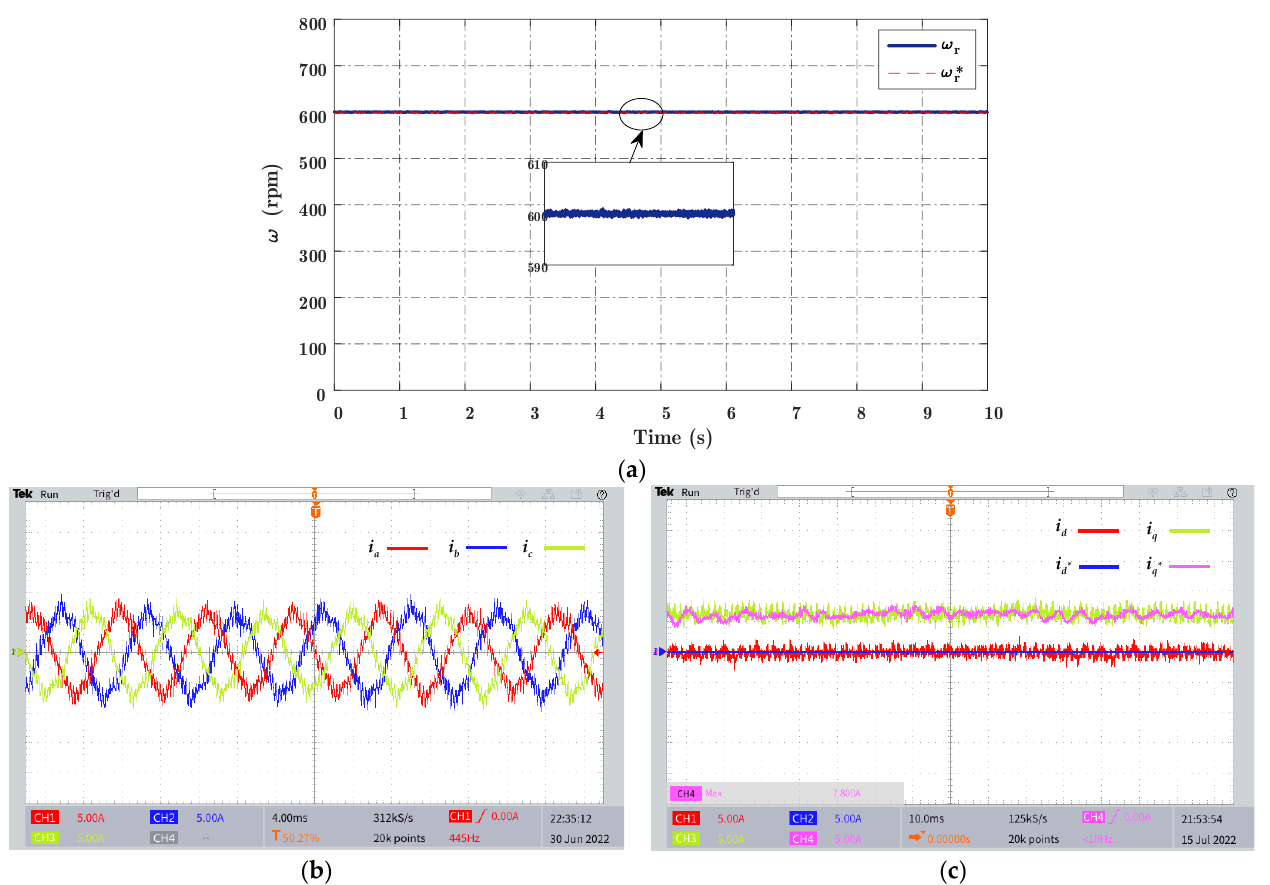
Figure 16. Electrical and mechanical characteristics in the healthy state. ( a ) Rotor speed; ( b ) stator phase currents; ( c ) direct and quadratic current component.